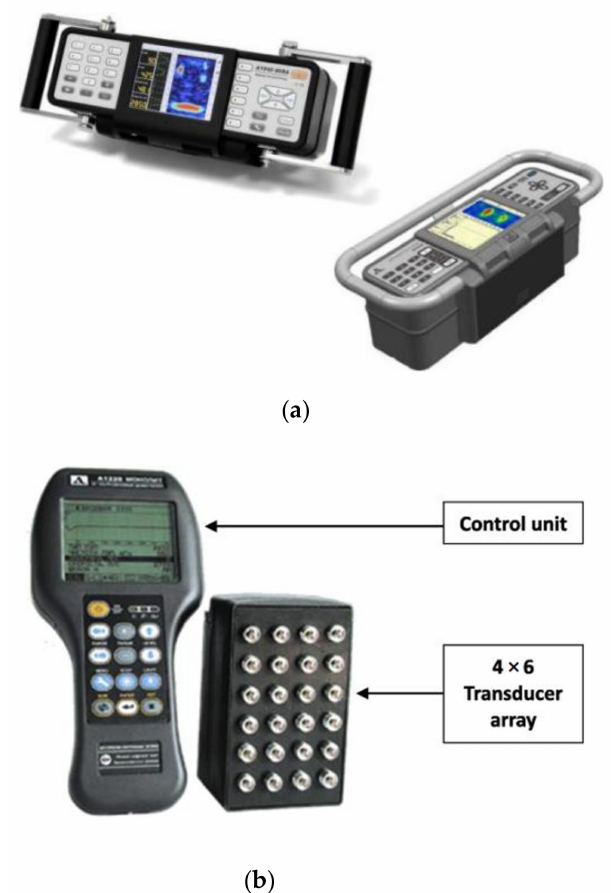
Figure 8. ( a ) View of prototypes for the Mira equipment (2nd generation), ( b ) View of the Eyecon system [99].